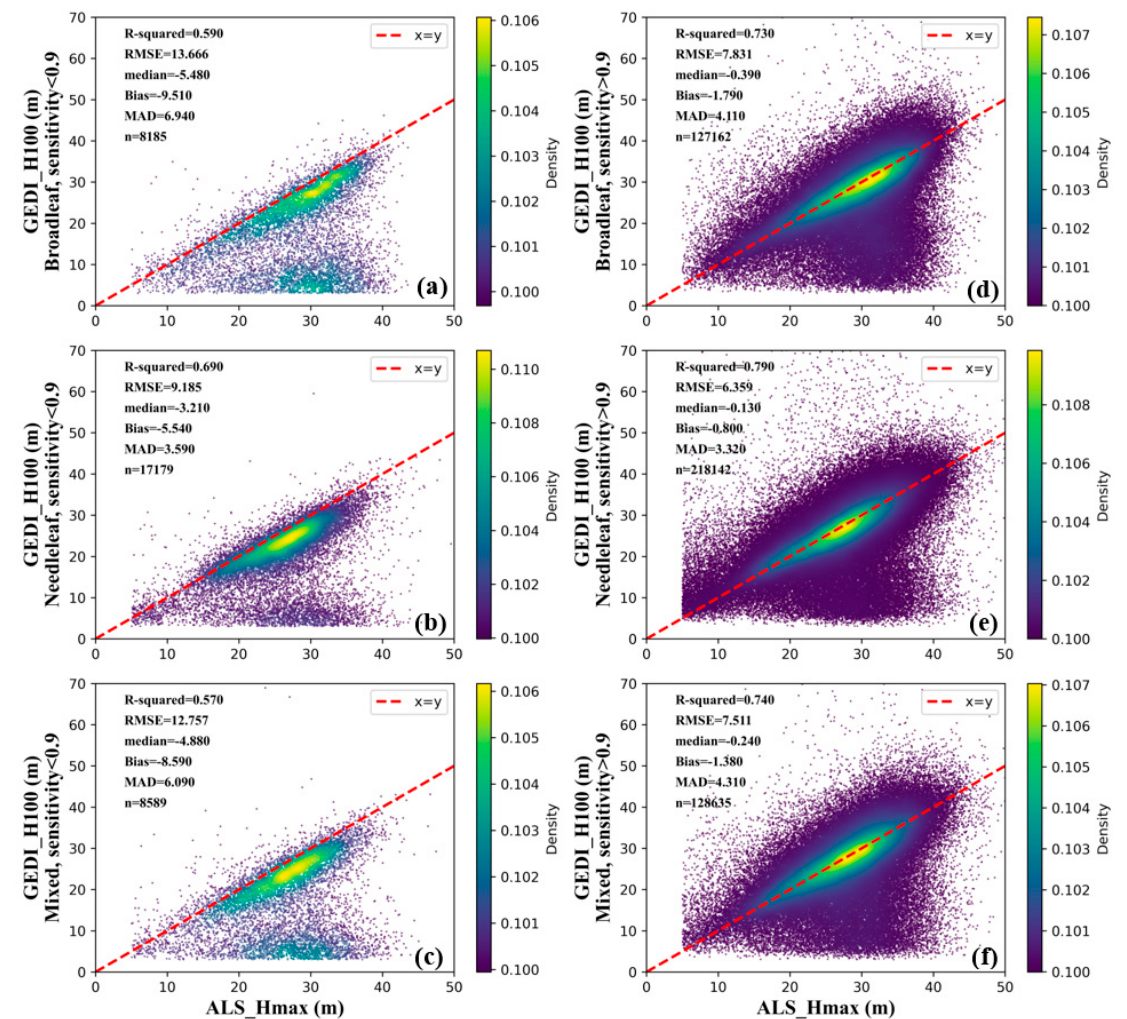
Figure 8. GEDI-H100 versus ALS-Hmax in the three forest types with sensitivity < 0.90 ( a , b , c ) and sensitivity > 0.90 ( d , e , f ).